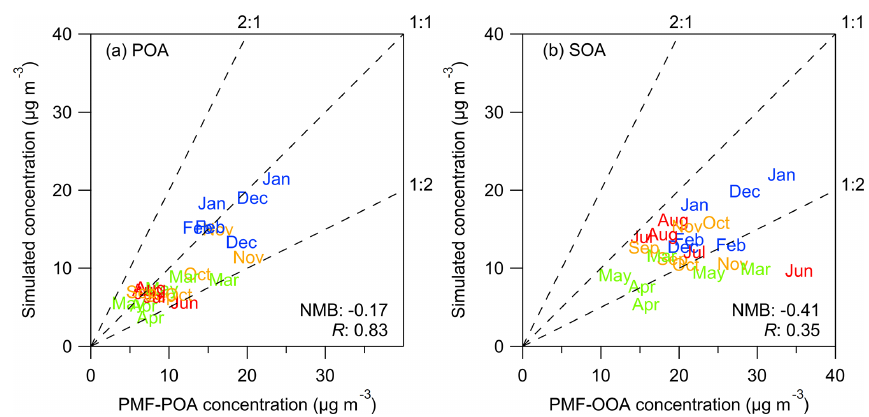
Figure 3. Scatterplots of the monthly mean concentrations of (a) simulated POA and PMF-derived POA and (b) simulated SOA and PMF- derived OOA at the IAP site in Beijing from July 2011 to May 2013. The observed concentrations were divided by a submicron-to-fine ratio of